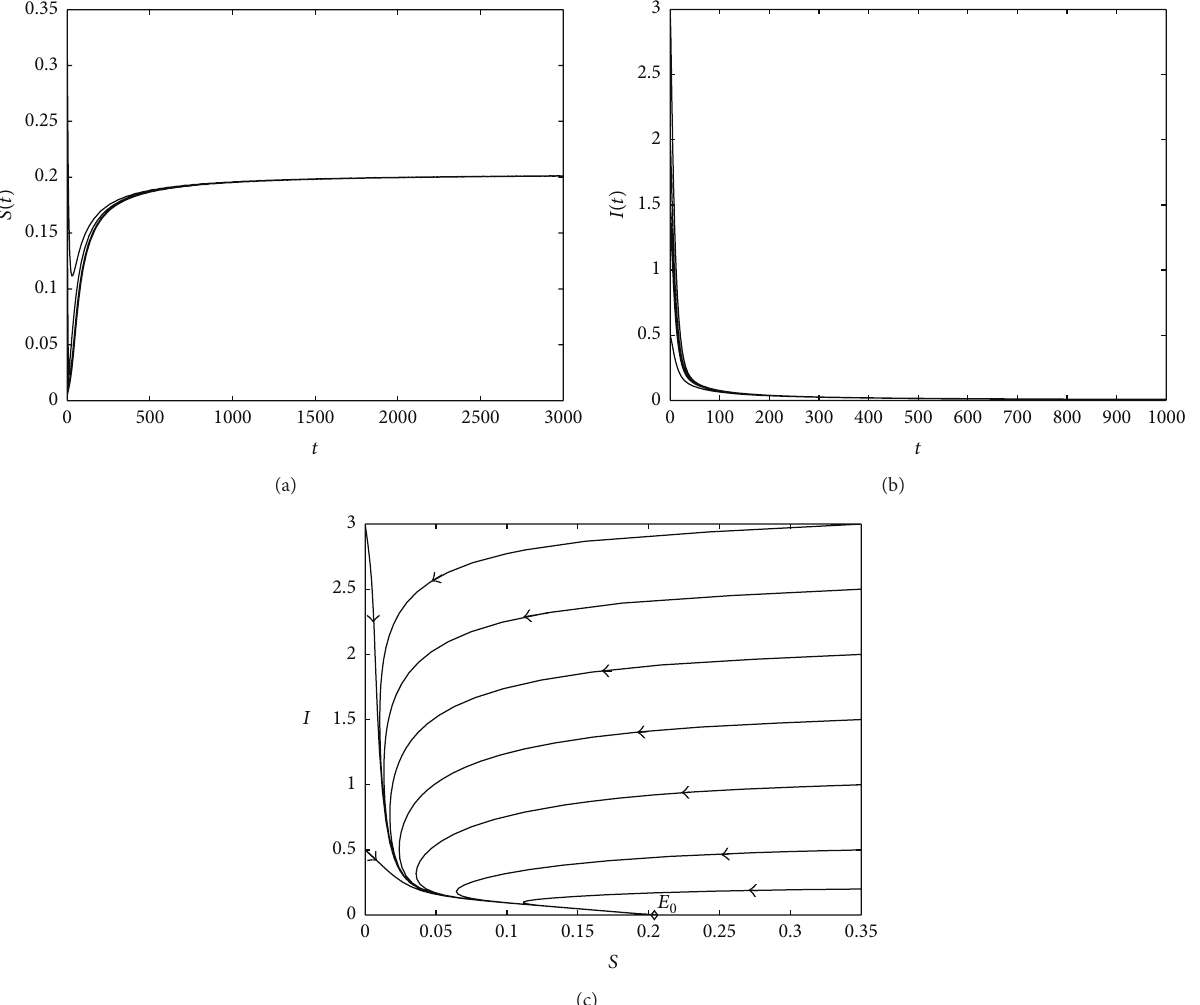
Figure 3: 𝜏 > 0 , 𝑅 0 = 1 . The solutions of system (6) tends to the disease-free equilibrium 𝐸 0 = (0.20405, 0) .